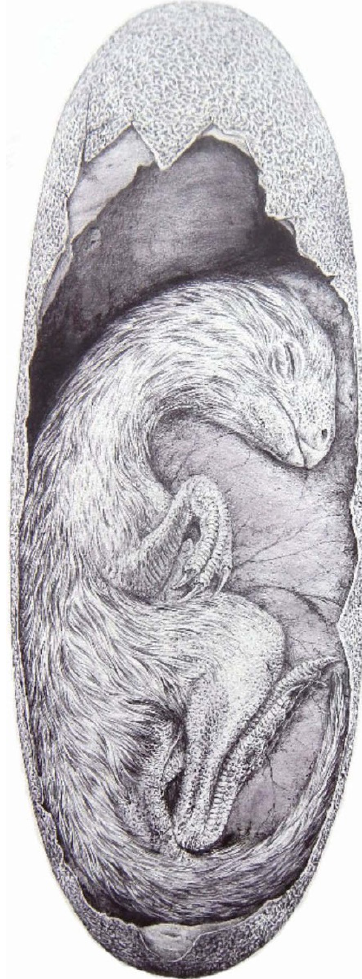
Figure 5 | Reconstruction of Beibeilong embryo in ovo . The drawing shows the approximate size of the Beibeilong embryo inside a Macroelongatoolithus egg (drawn by Vladimir Rimbala).